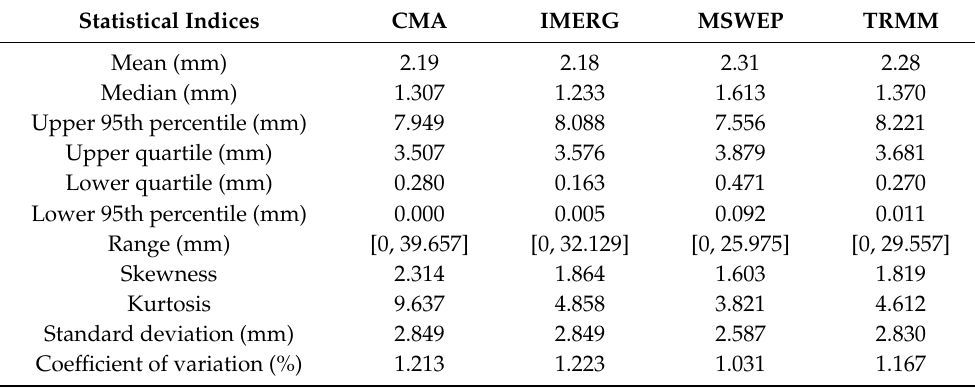
Figure 3. Categorical statistical indices (( a ) POD , ( b ) FAR , ( c ) BIAS , and ( d ) CSI ) of the three precipitation products at a daily scale. Table 3. Comparison of daily statistical results of the precipitation products.